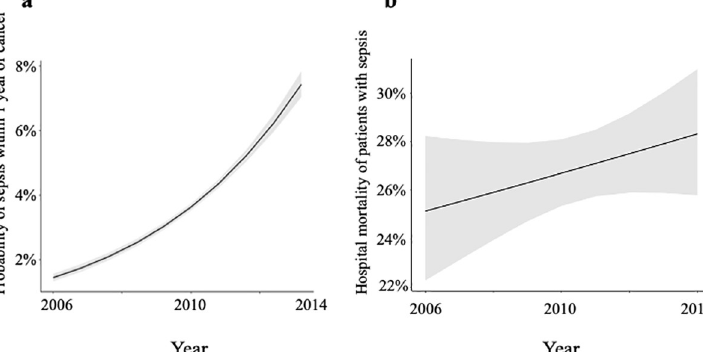
Fig 1. Time course over the study period (2006–2014) of unadjusted probability of sepsis within 1 year for patients with a new cancer diagnosis (Fig 1(A)) and unadjusted hospital mortality for the subset of patients admitted with sepsis (Fig 1(B)). Black lines represent the unadjusted probabilities and grey areas represent the 95% confidence